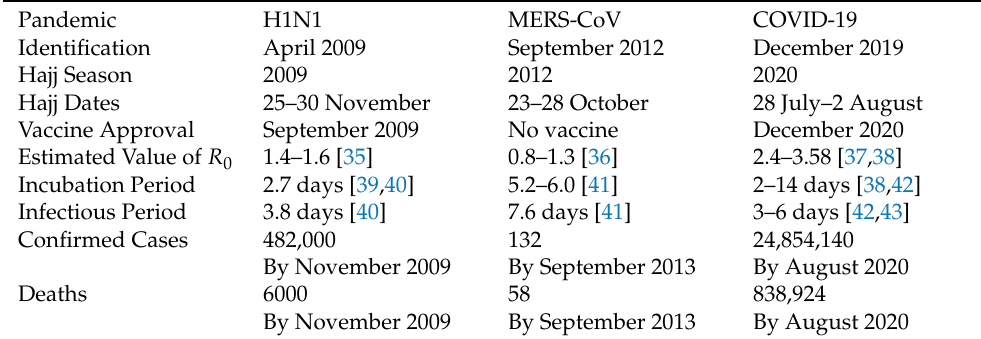
Table 2. Major disease outbreaks of novel viruses and the affected Hajj